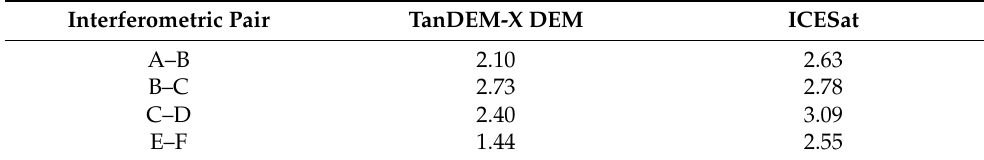
Table 9. DEM accuracy evaluation results (unit: m).